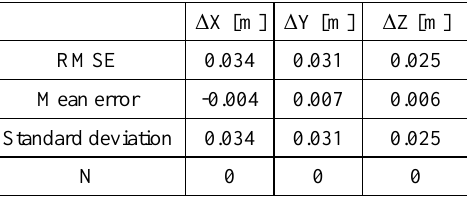
Table 3. Computed accuracy measures